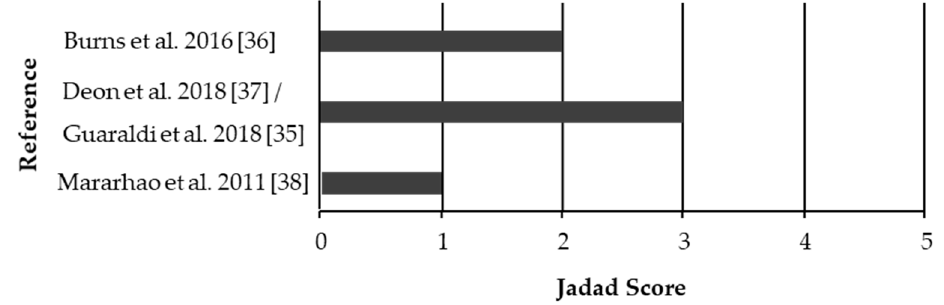
Figure 2. Quality assessment scores of eligible studies using the Jadad scoring system [33]. Articles were scored by two independent reviewers and no conflicts needed to be resolved.